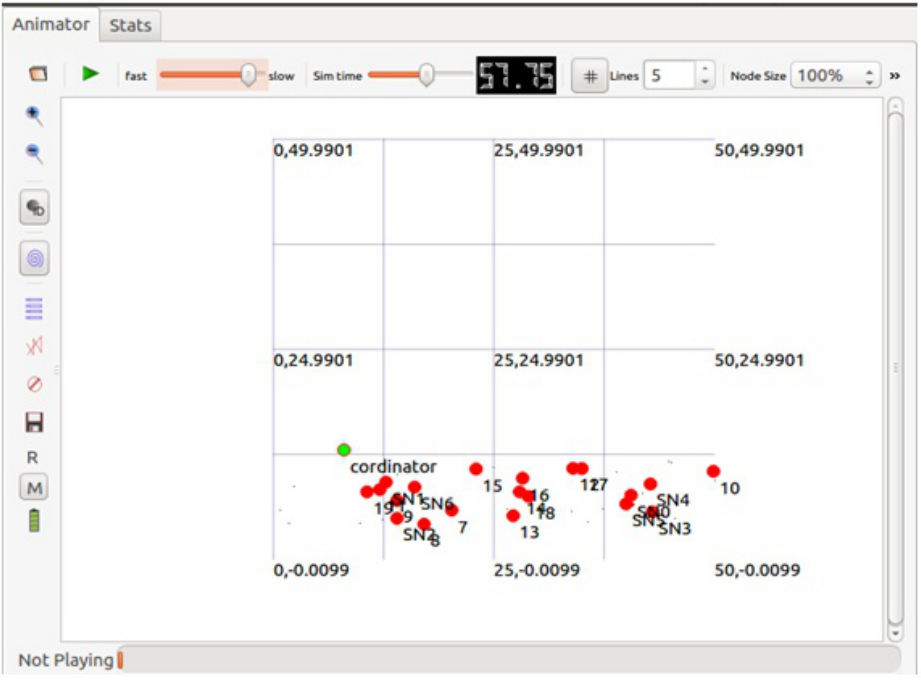
Figure 7. ns-3.20 nam